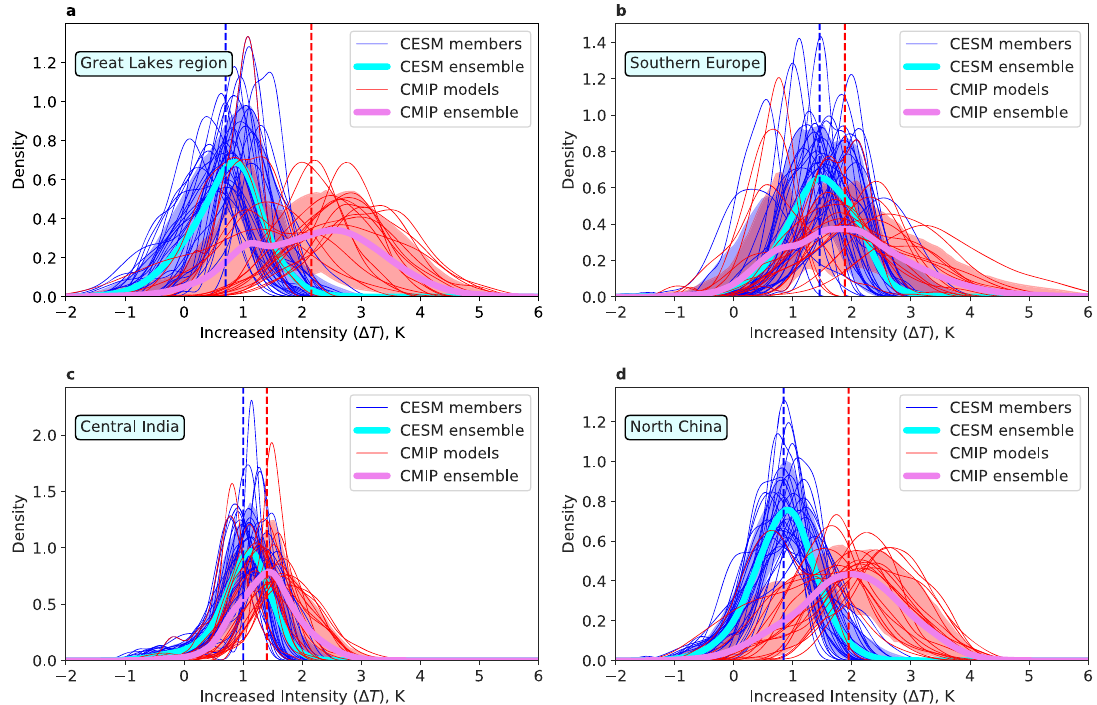
Fig. 4 Probability distribution of changes in urban heat wave intensity by 2061 – 2070. The thick lines mark the CMIP5 multi-model mean (thick violet lines) and CESM-LE multi-member mean (thick cyan lines). The thin red lines mark individual models of CMIP5; the thin blue lines mark individual CESM- LE members. The red and blue shading denote the 5th to 95th percentile across CMIP5 models and across CESM members respectively for each small bin. The changes are derived from land grid points in a Great Lakes region (36.15 – 49.5 ∘ N, 95 – 75 ∘ W), b Southern Europe (40 – 50 ∘ N, 15 – 30 ∘ E), c Central